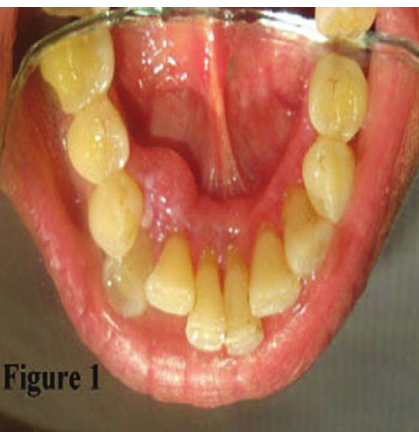
Figure 4: H and E-stained section shows ameloblastic follicles with basaloid pattern (10 × ).